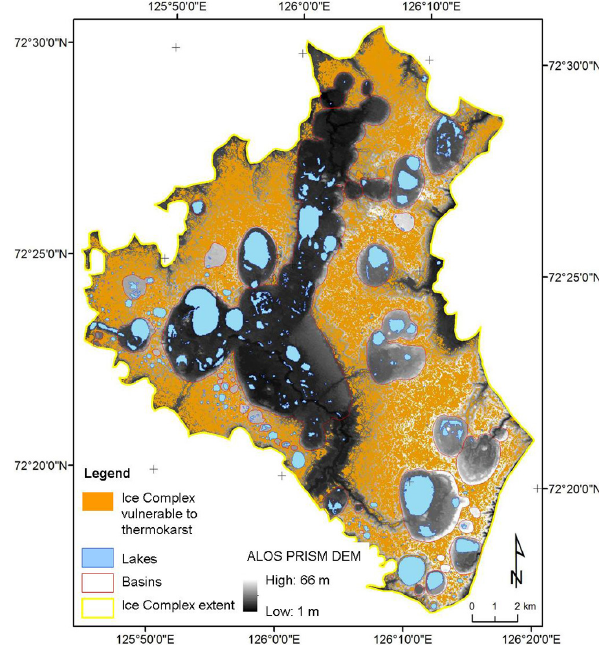
Fig. 10. DEM of Kurungnakh Island indicating the position of thermokarst features above and below the Ice Complex boundary at 17m a.s.l. Of the total Kurungnakh Island area, 28.1% is cov- ered by features under which the Ice Complex deposits should have already completely degraded. The line between a and a’ indicates a profile section across a Yedoma and thermokarst basin assemblage (see Fig. 11).